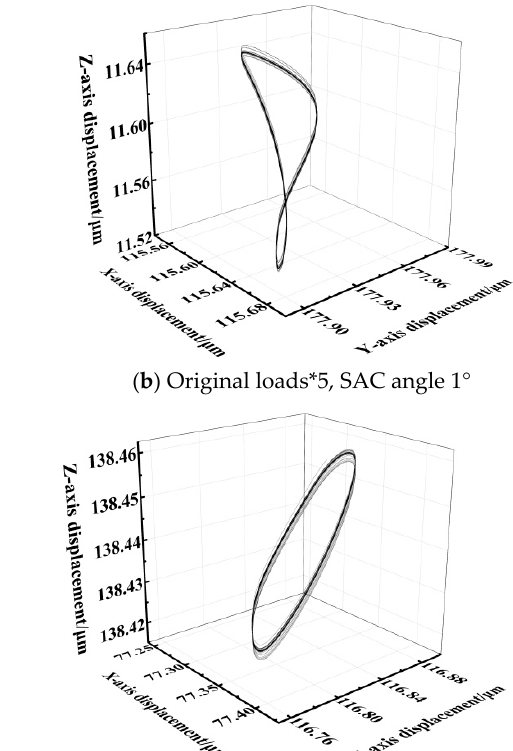
Figure 19. The normal displacements of two ‐ row rollers under the same operating condition are shown in Figure 18d.